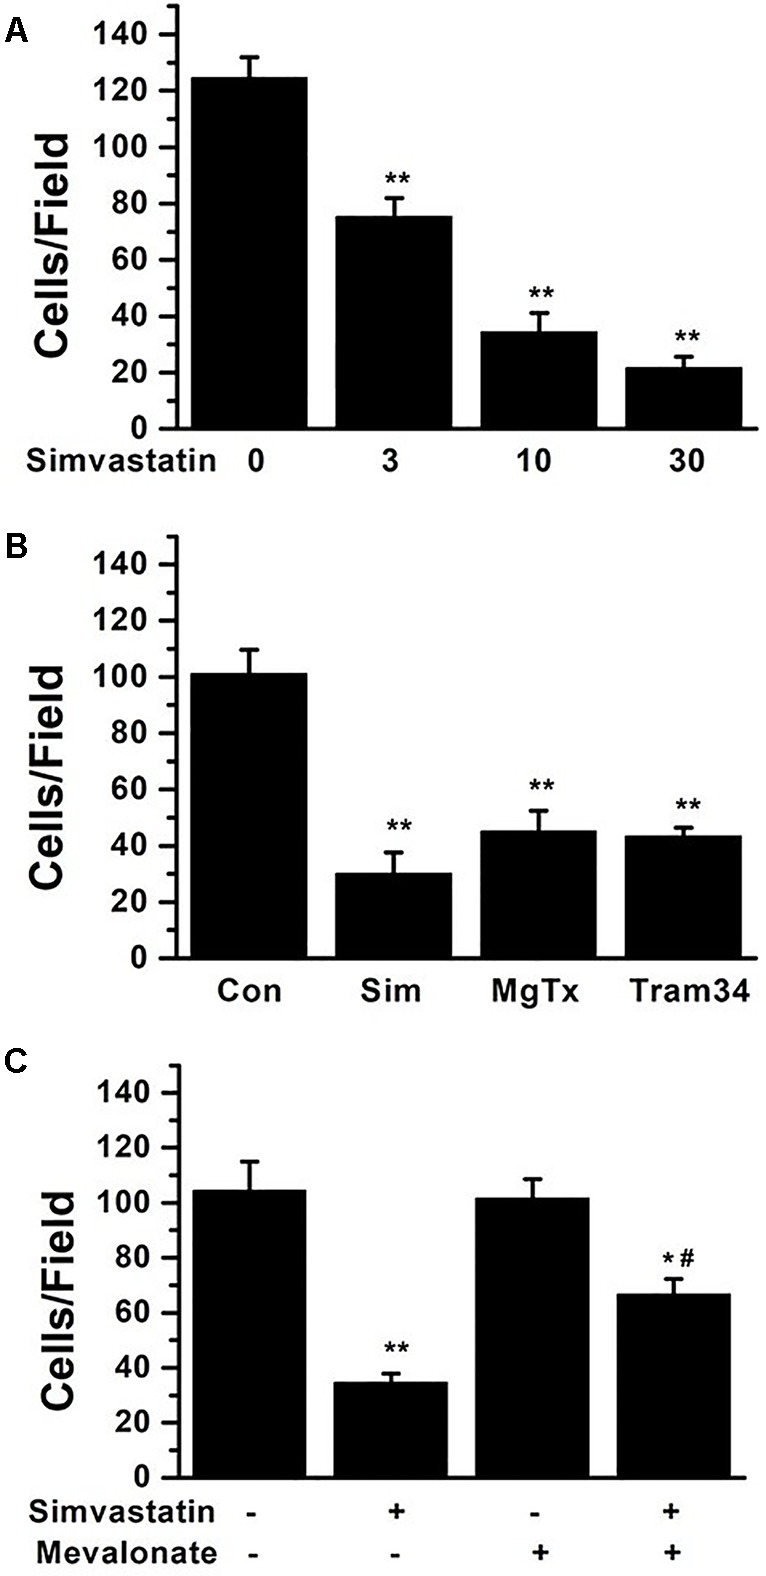
THP-1 cell migration induced by 2 nM MCP-1 was determined by immunocytochemistry in transwell cell chambers. (A) THP-1 cells were seeded and incubated with 0, 3, 10, or 30 µM simvastatin. The summarized data from at least 5 duplicates was expressed as mean ± SEM. **P < 0.01, vs. 0 µM simvastatin. (B) 10 µM simvastatin, 1 nM MgTX, and 1µM Tram-34 treatments significantly inhibited cell migration compared with controls, **
P < 0.01; n = 8 for each group. (C) THP-1 cells were treated using 10 µM simvastatin with or without 100 μM mevalonate application, *P < 0.05 and **P < 0.01, vs. controls group without either simvastatin or mevalonate, #
P < 0.05, vs. group with simvastatin only; n = 8 for each group.